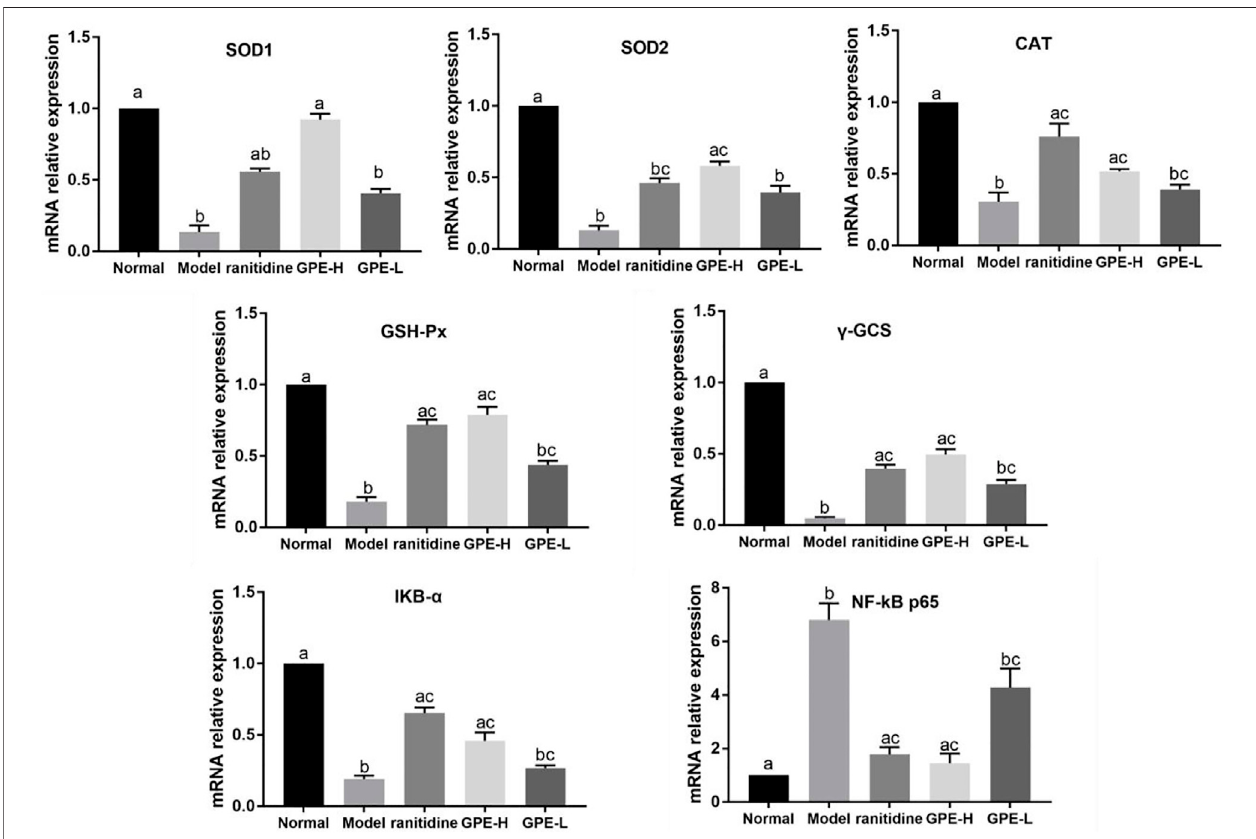
FIGURE 7 | mRNA expression levels of SOD1 , SOD2 , CAT , γ -GCS , GSH-Px, NF- κ B p65 and I κ B α in gastric tissue of the different groups were investigated by qPCR. The data are shown as mean ± SD (n (cid:2) 8). a – c Mean values with different letters are signi fi cant difference ( p < 0.05) according to analysis of